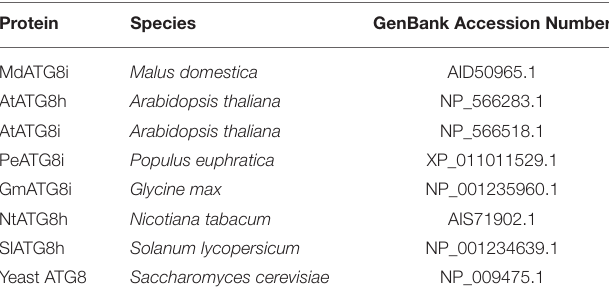
TABLE 2 | GenBank Accession Numbers for proteins used to construct phylogenetic trees.